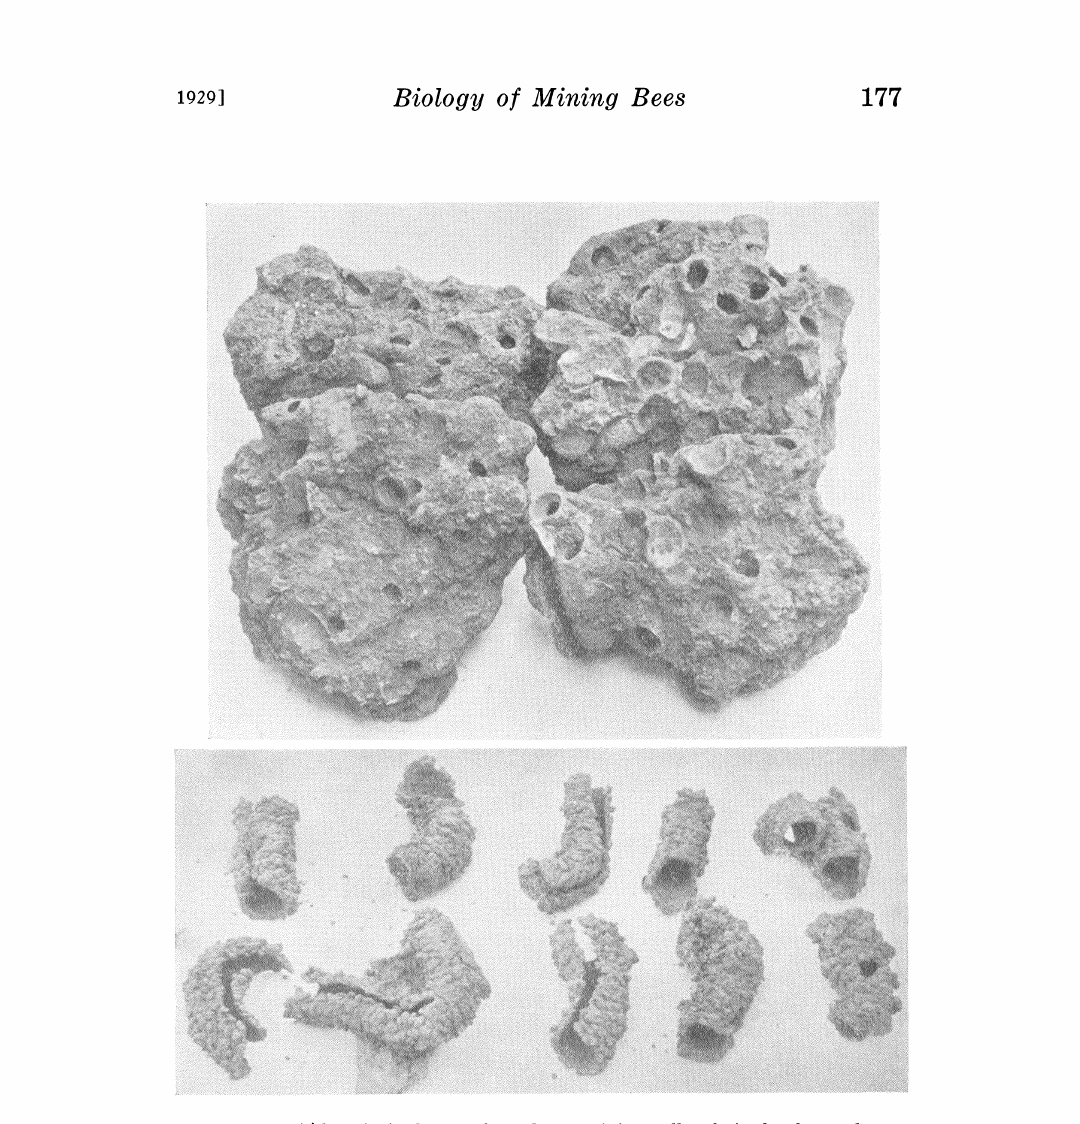
Fig. 12. (Above) A clump of earth containing cells of Anthophora abrupta (3 natural size). Fig. 13. (Below) The turrets of the white-banded bee Entechnia taurea (slightly